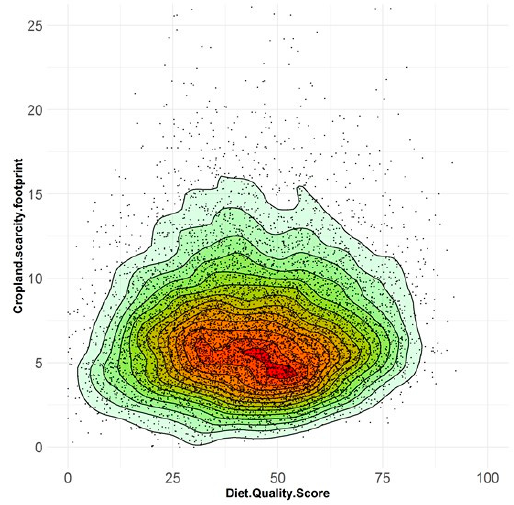
Figure 2. Cropland scarcity footprint (m 2 ye person − 1 day − 1 ) and diet quality score (range 0–100). Scatterplot showing diversity of individual adult daily diets reported in the Australian Health Survey ( n = 9341). Shading indicates density of points from high (red) to low (green).